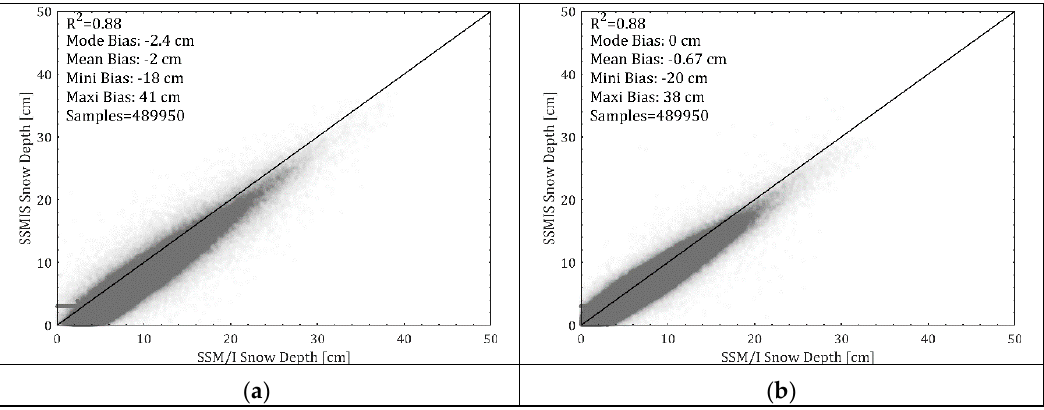
Figure 9. Scatter plots of snow depth estimated with the same algorithm but different satellite observations (SSM/I vs. SSMIS). ( a ) dual-channel algorithm; ( b ) multichannel algorithm.